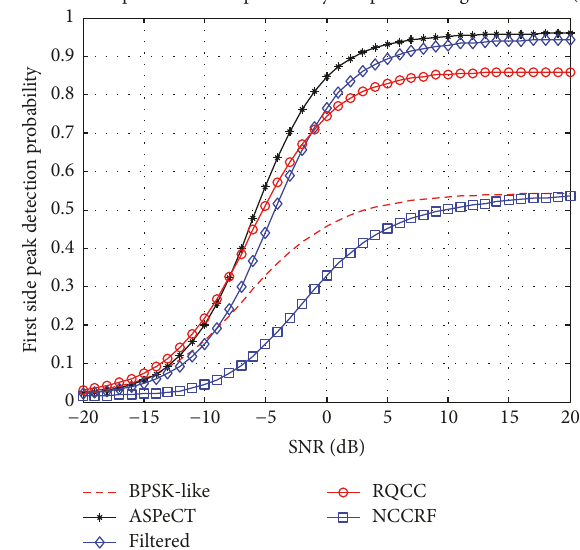
Figure 19: The FSPDR comparison of BOC ( 8, 4 ).